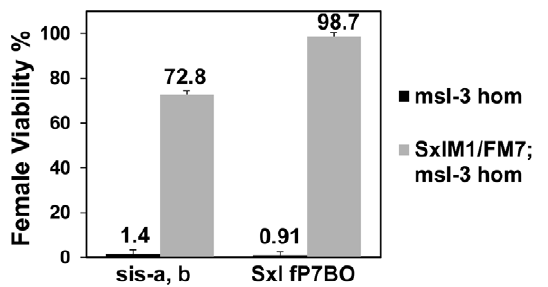
Figure 4. A constitutive Sxl allele rescues the female lethality from loss of msl-3 . y,cm,Sxl M1 /FM7; msl-3 1 females mated to w, sis-b sc3-1 ,sis-a 1 ,m /Y or y,w, cm, Sxl fP7B0 /Y males (test class total n=555, 851, 1065, 681 respectively). Percent viability of females relative to their brothers is shown with percentage standard error. Genotype of fathers shown on x-axis. As the reference males were the balancer FM7/Y, correction for their reduced viability (48.7%) was determined relative to Sxl M1 / + females from a mating of y, cm, Sxl M1 /